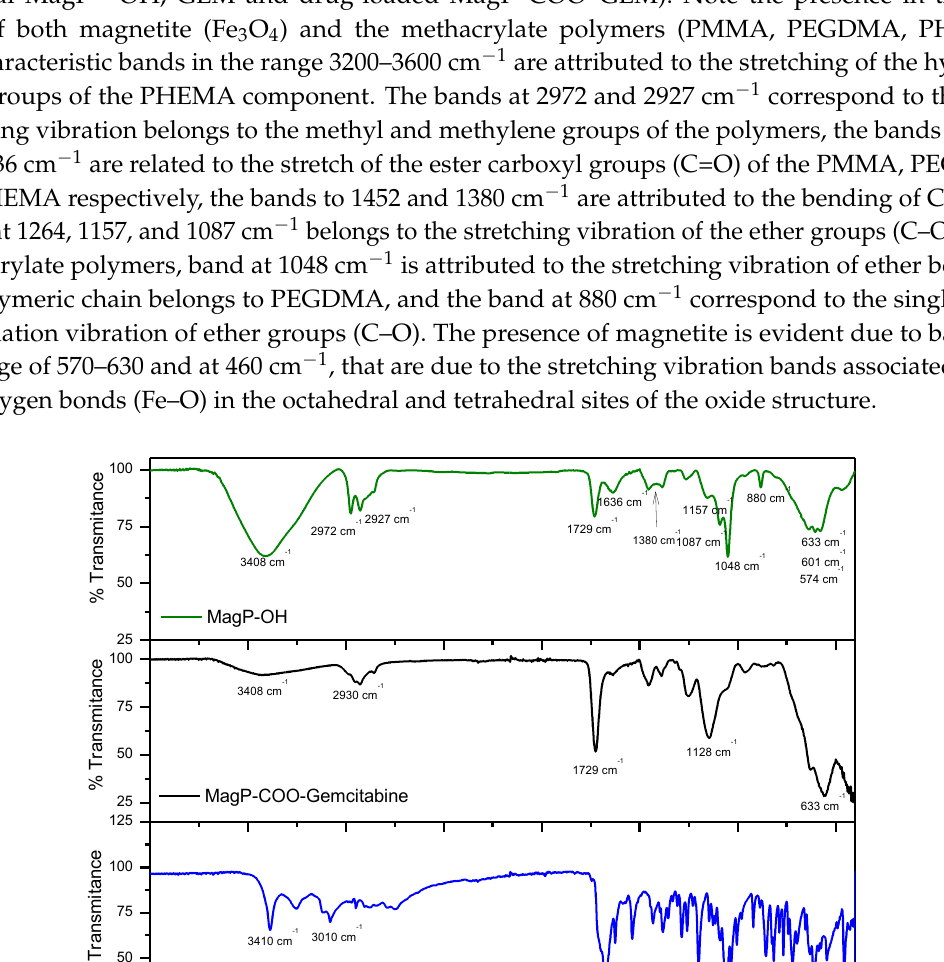
Table 1. GEM adsorbed on MagP – COOH NPs for different initial drug/MNPs ratios.